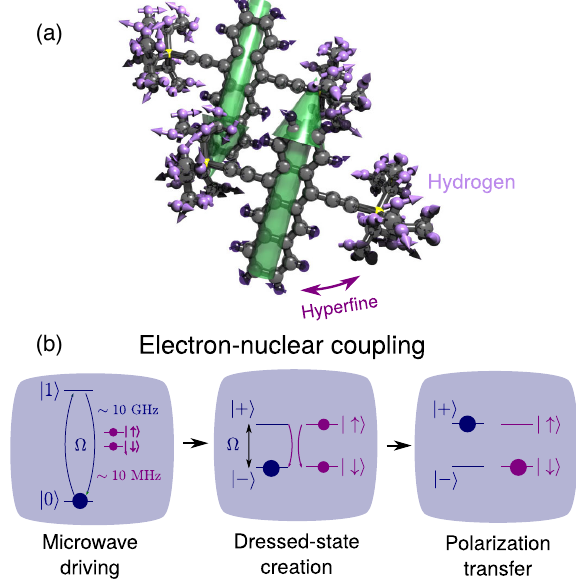
FIG. 5. State- and site-selective electron-nuclear coupling in a singlet fission material. (a) Selectively deuterated TIPS-tetracene with photoexcited triplet pair (green) showing coupling to hydrogen nuclear spins on the side groups. (b) Schematic of electron-nuclear coupling under spin-locking conditions showing microwave driving to form dressed states with a Rabi splitting matching the ∼ 10 MHz nuclear spin splitting, allowing coherent electron-nuclear evolution and polarization transfer.